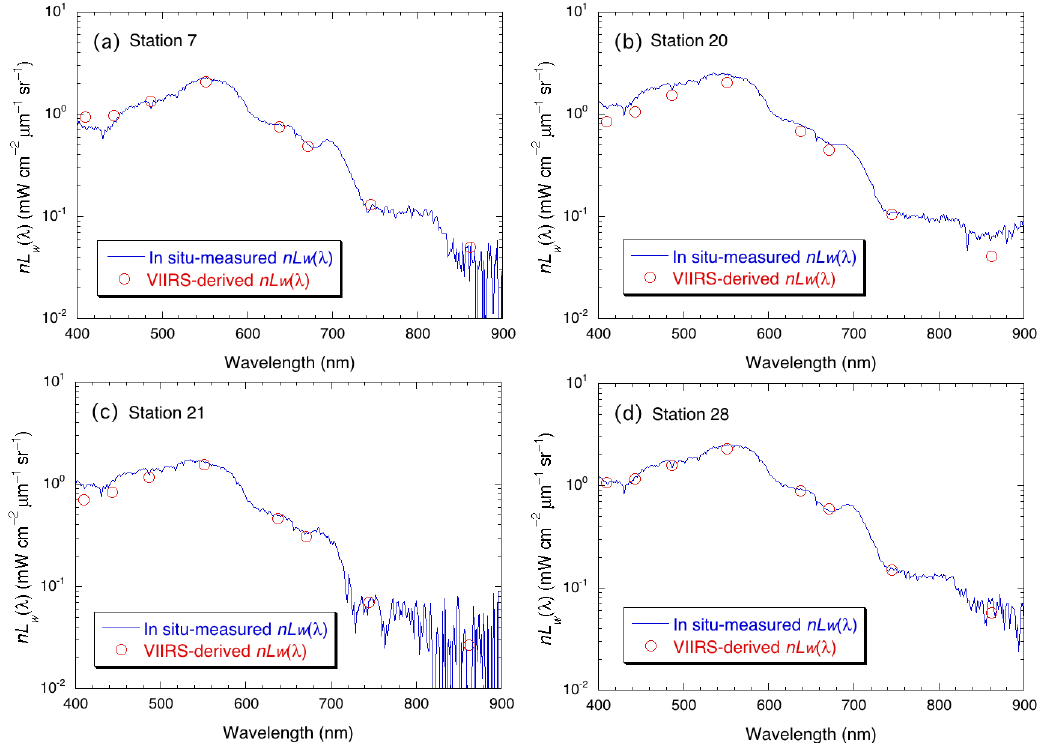
Figure 2. The Visible Infrared Imaging Radiometer Suite on the Suomi National Polar-orbiting Partnership (VIIRS-SNPP)-derived nL w ( λ ) spectra (red circles), compared with in-situ-measured hyperspectral at ( a ) Station 7, ( b ) Station 20, ( c ) Station 21, and ( d ) Station 28 in the Great Lakes.